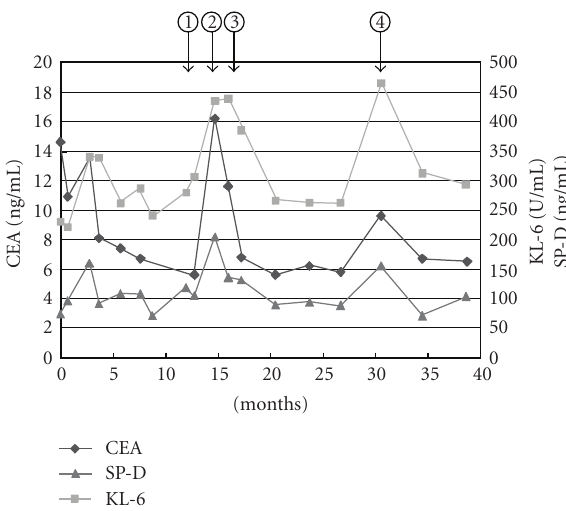
Figure 6: Serial changes of serum CEA, KL-6, and SP-D. (1) At 12 months after SBRT, mass-like consolidation appeared in the irradiated area. (2) At 15 months, the mass-like consolidation enlarged at the dorsal side and serum CEA increased accompanied by KL-6 and SP-D. (3) At 16 months, serum CEA was slightly decreased. (4) At 31 months, minimal lung opacities suggesting pneumonia in the left lower lobe were observed on CT images, but no significant change was seen in the irradiated